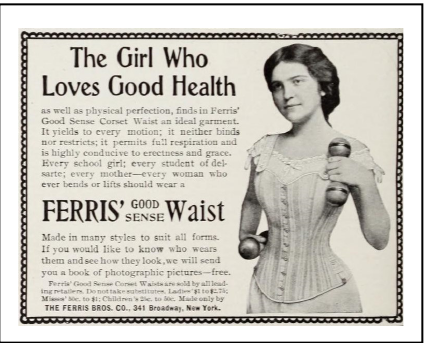
Figure 7. Bodily Perfection. Christian Herald , 12 April 1899, p. 286.